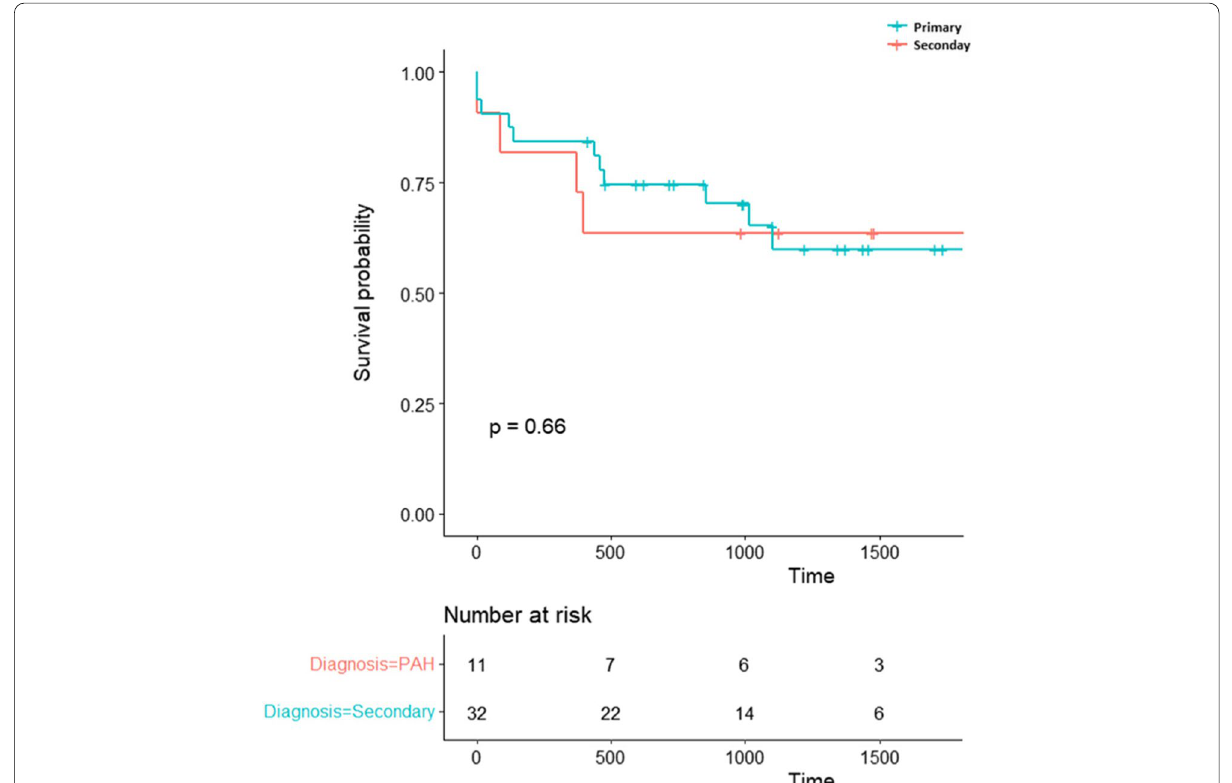
Fig. 1 Comparison between primary vs secondary PAH survival probability after